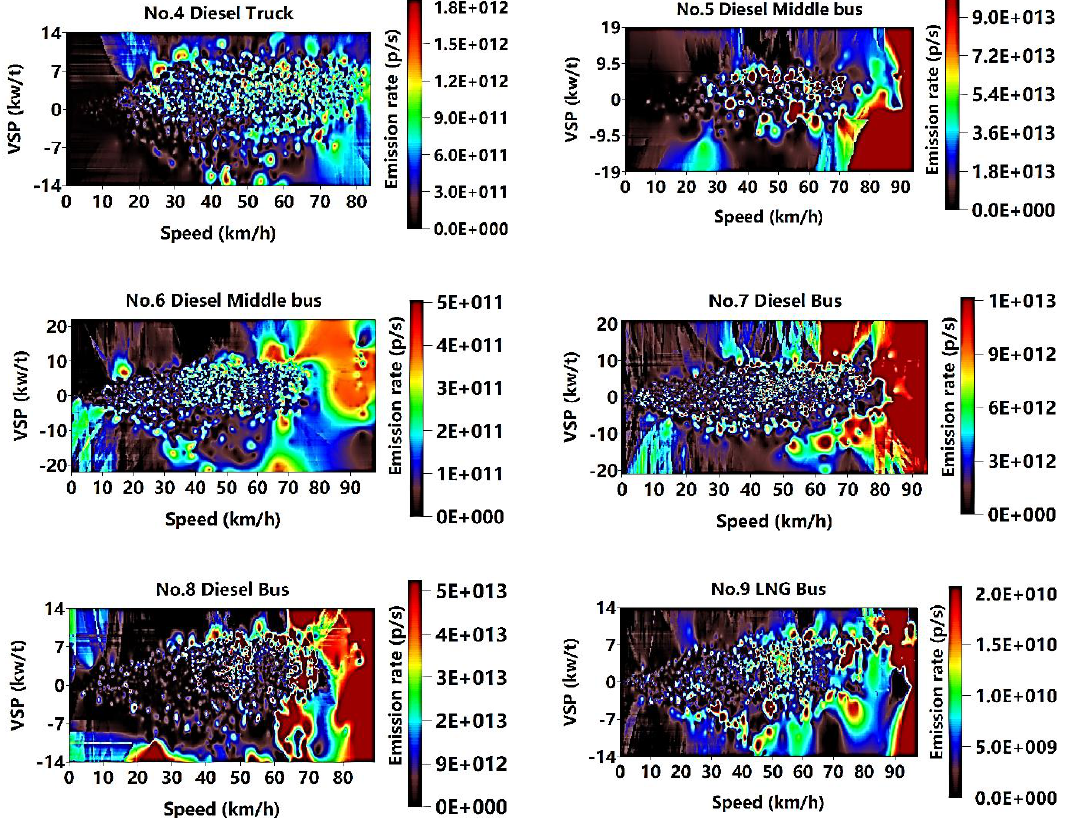
Figure 5. The image maps of the relationship between speed-VSP and PN emission rates. PN emission rates are represented by the colors. The black, brown, blue, cyan, green, yellow, orange, red, and ruby red areas indicate that the emission rates are approximately 0, 0.5, 1, 1.5, 2, 2.5, 3, 3.5, and over 4